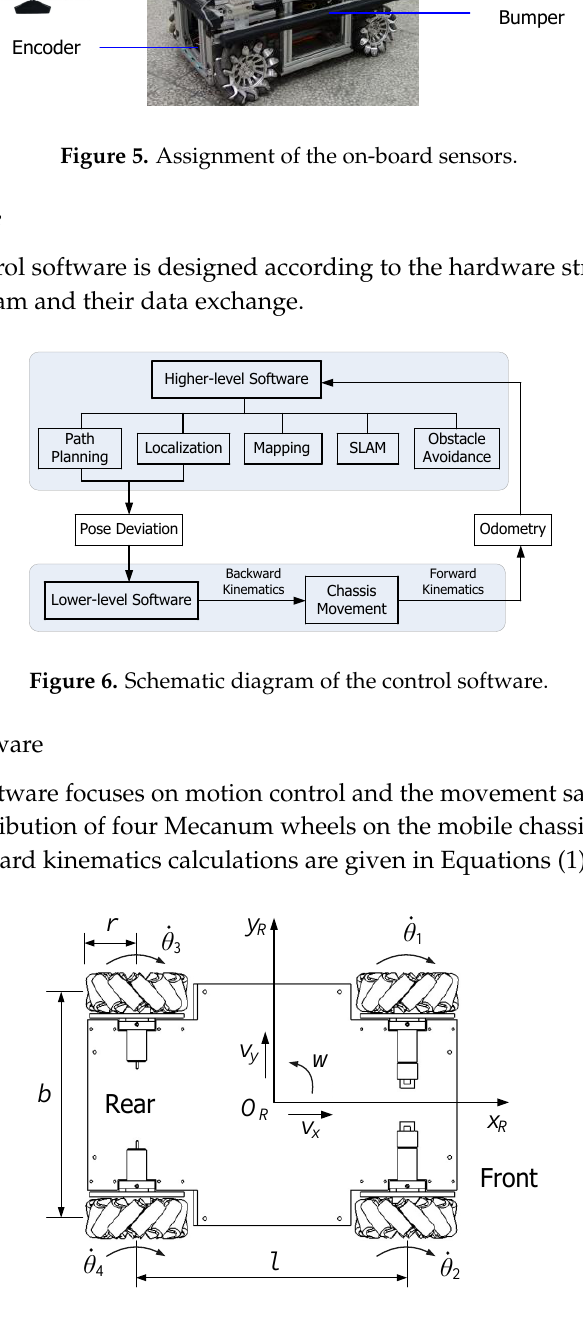
Figure 7. The distribution of the four wheels and their movements.